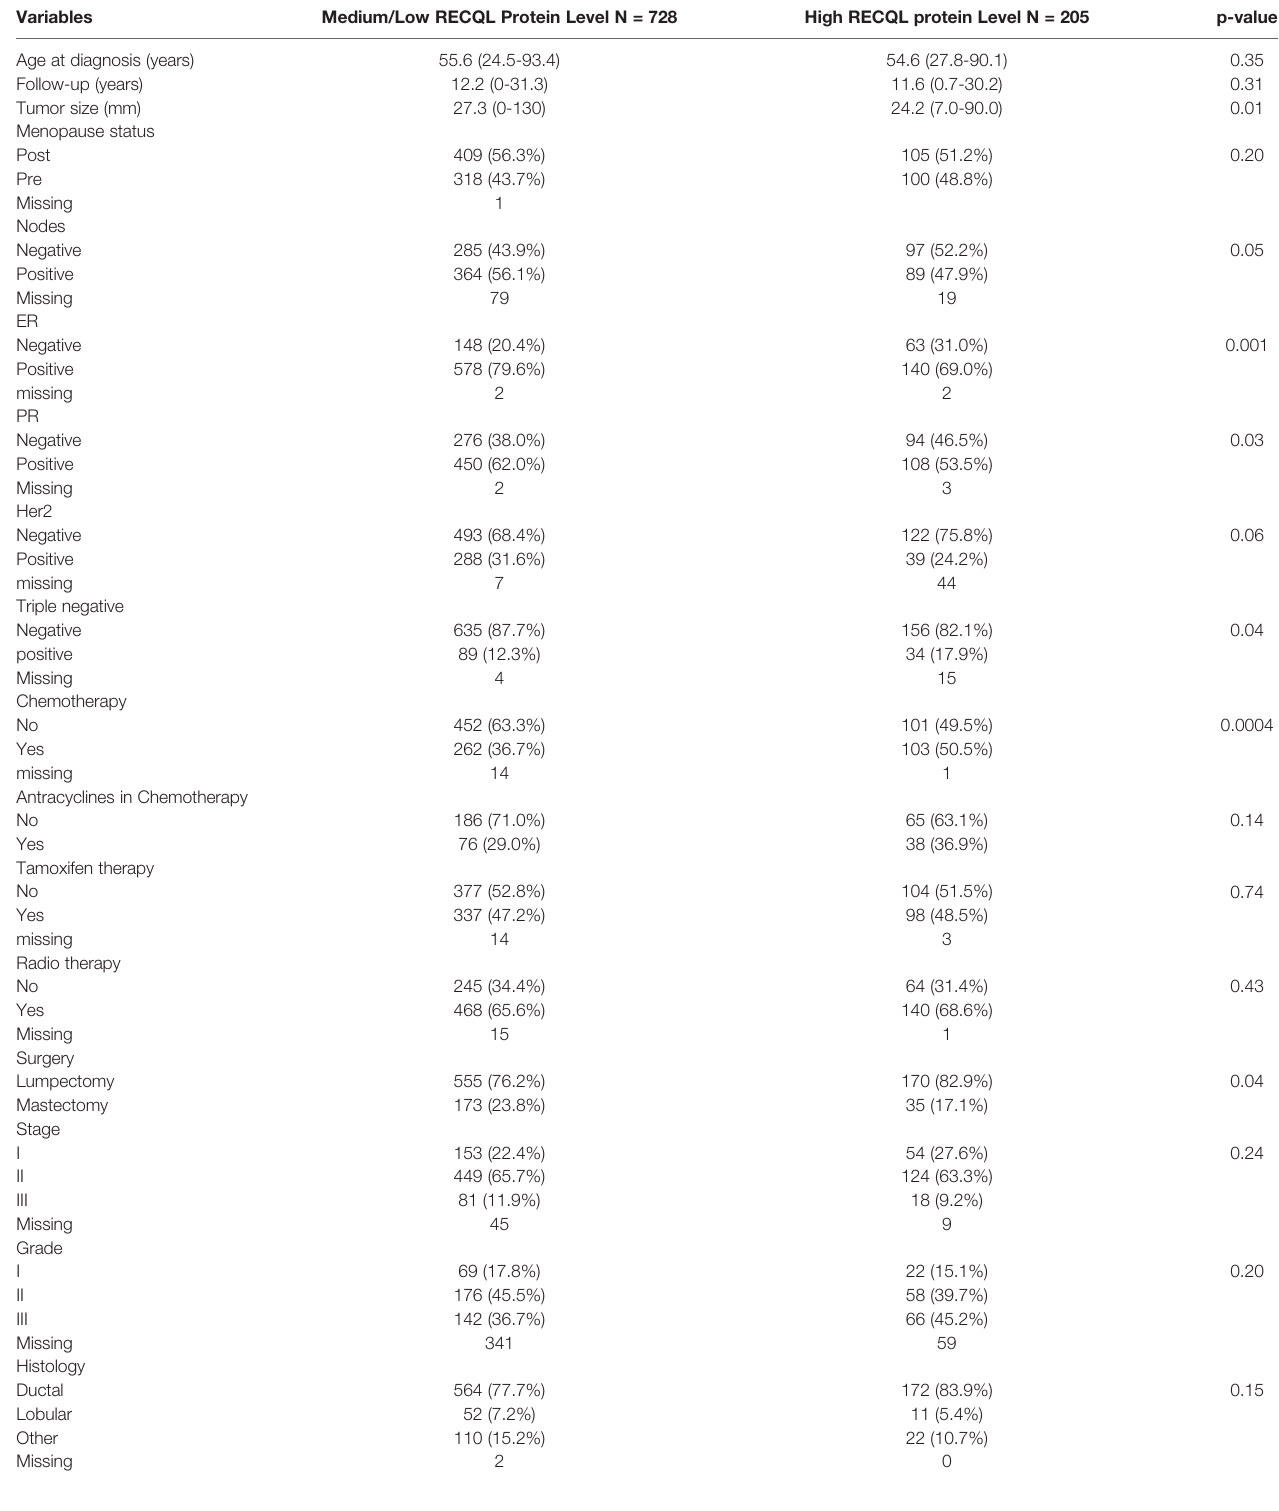
TABLE 1 | Comparison of clinicopathological characteristics between patients with medium/low versus high RECQL protein